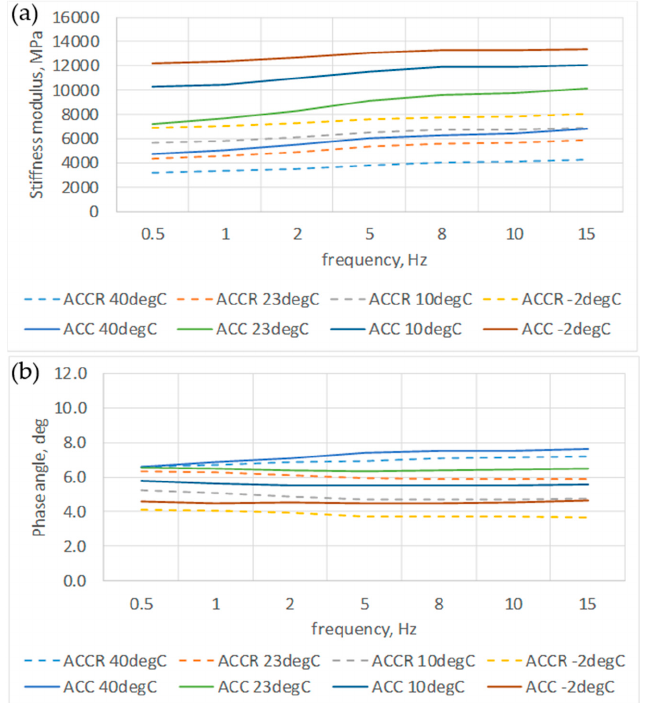
Figure 12. Stiffness modulus E and phase angle vs. frequency for ACC with 20% of “B” CSR mortar and ACC with 20% cement-sand mortar (C:S = 1:1) ( a ) stiffness modulus; ( b ) phase angle φ .